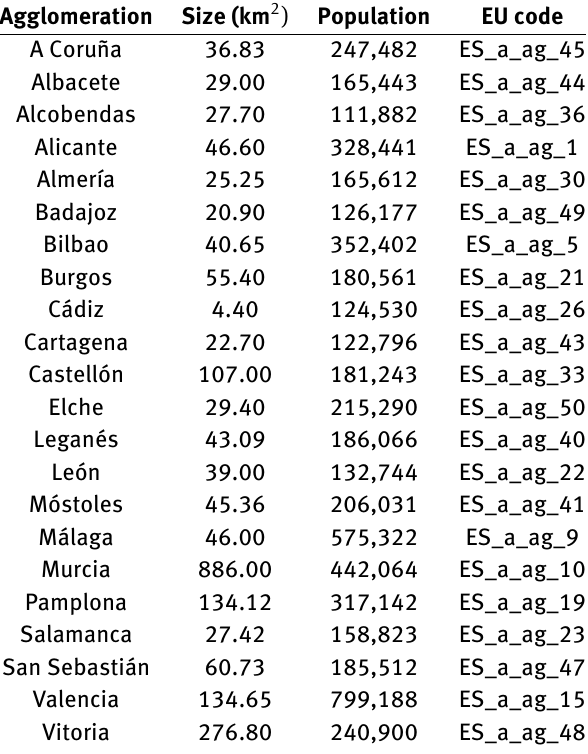
Table 1: Strategic noise maps in Spain (Agglomerations). Phase